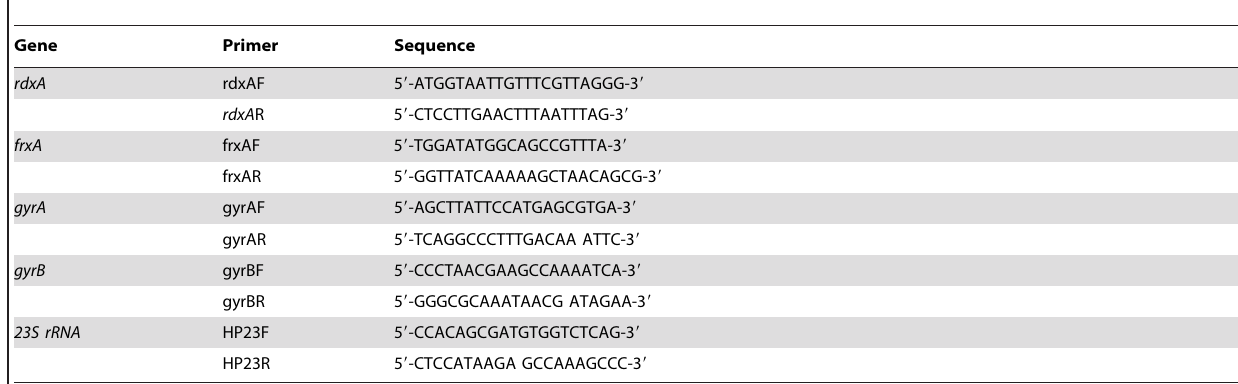
Table 1. Oligonucleotide primers for amplifying rdxA , frxA 23S rRNA , gyrA and gyrB .